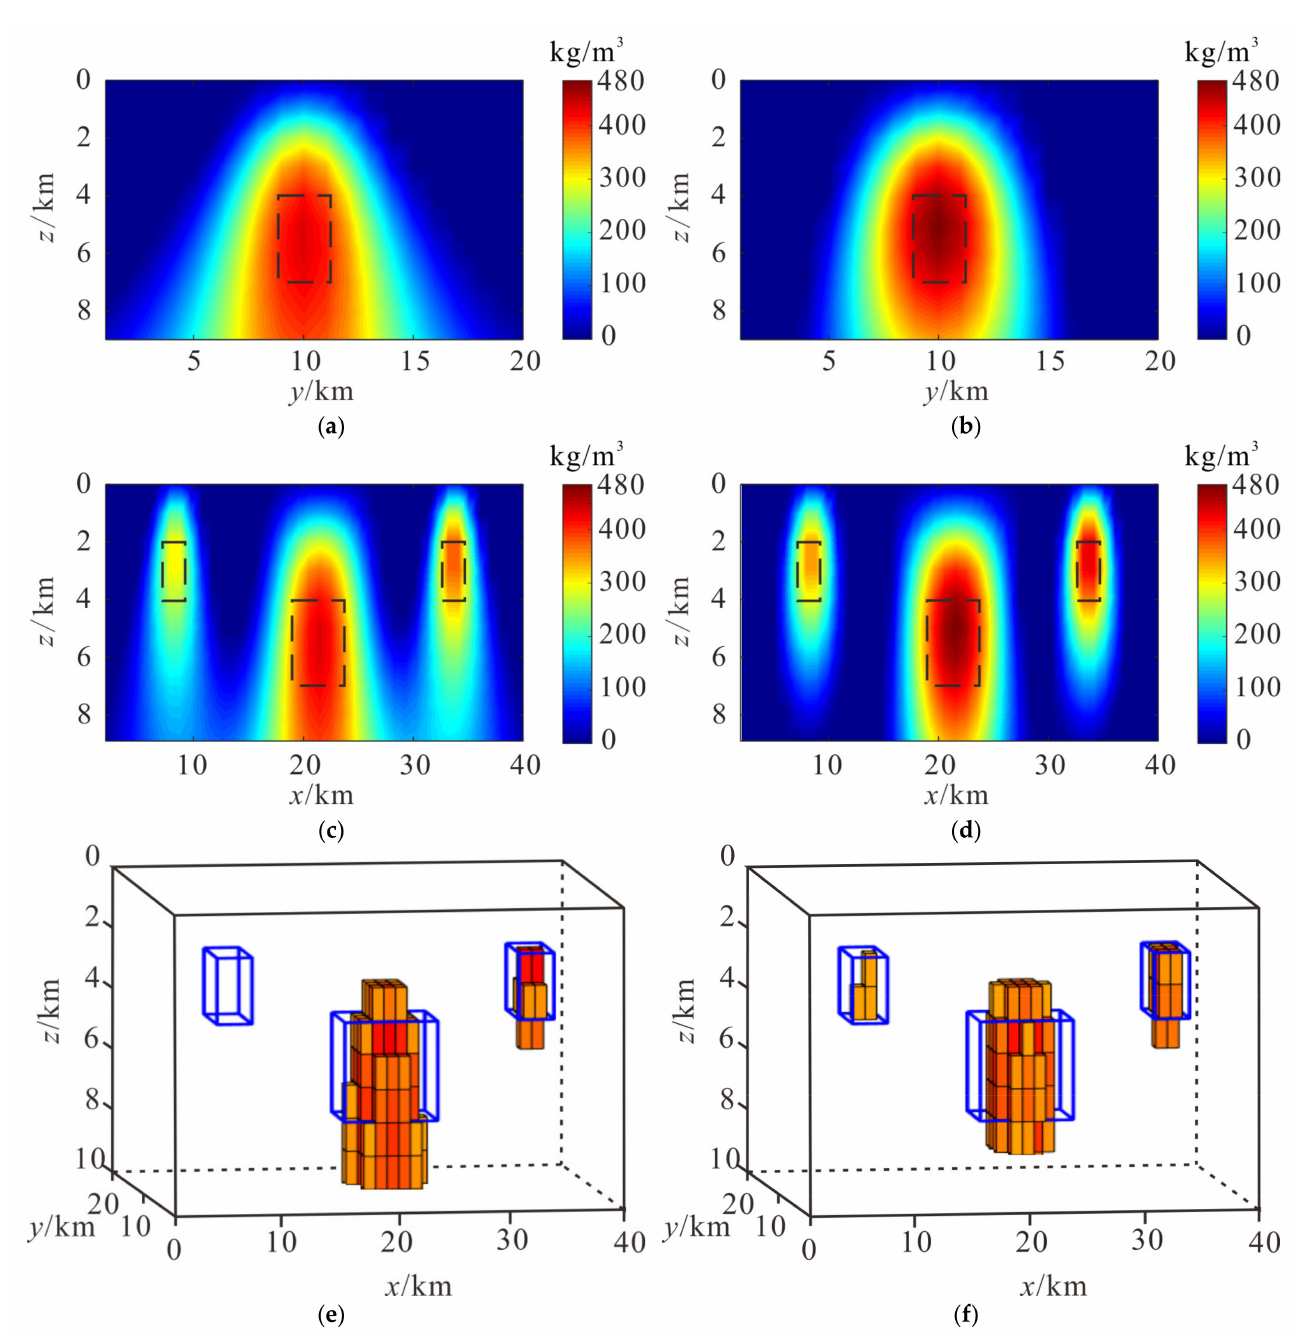
Figure 9. Complex model tests of three prisms. ( a ) Density slice (x = 10 km) by data combined joint inversion method of airborne gravity and its gradient data. ( b ) Density slice (x = 10 km) by cooperate density-integrated inversion method. ( c ) Density slice (y = 10 km) by data combined joint inversion method of airborne gravity and its gradient data. ( d ) Density slice (y = 10 km) by the cooperate density-integrated inversion method. ( e ) 3D density distribution (larger than 370 kg/m 3 ) by data combined joint inversion method of airborne gravity and its gradient data. ( f ) 3D density distribution (larger than 370 kg/m 3 ) by the cooperate density-integrated inversion method of airborne gravity and its gradient